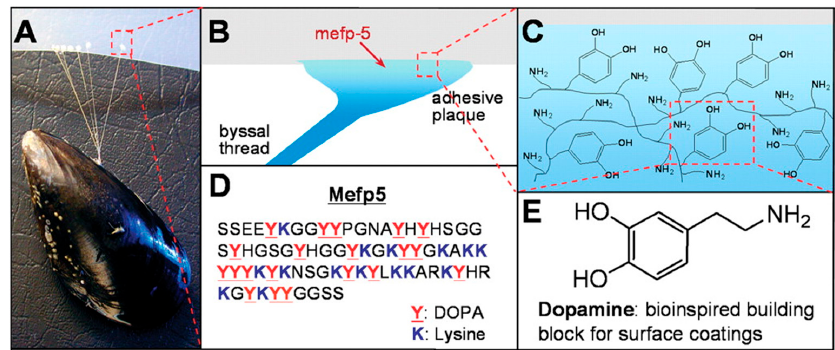
Figure 2. Mussel ( mytilus edulis ) attached to poly(tetrafluoroethylene) ( A ). Simplified schematic illustration of the interface between mussel byssi and substrate ( B ). Simplified molecular structure of PDA depicting the amine and catechol groups ( C ). Amino acid sequence of mytilus edulis foot protein 5 ( D ). Lewis formula of dopamine ( E ). From reference [17]. Reprinted with permission from the American Association for the Advancement of Science (AAAS).